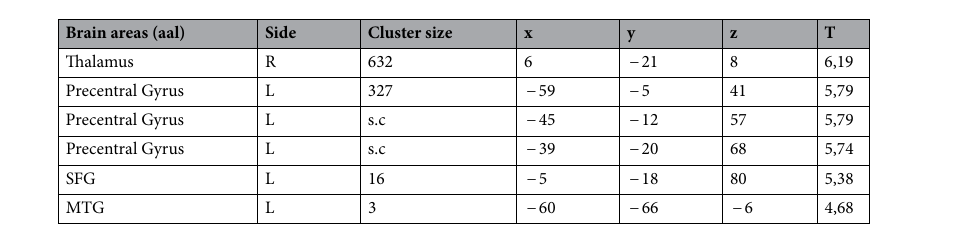
Figure 2. Whole-brain v-FWE corrected sex-specific VBM analyses. ( A ) HeM vs. HoM contrast; ( B ) HeW vs. HoW contrast; ( C ) Overlay of both ( A and B ) contrasts. HeM heterosexual men; HoM homosexual men; HeW heterosexual women; HoW homosexual women.